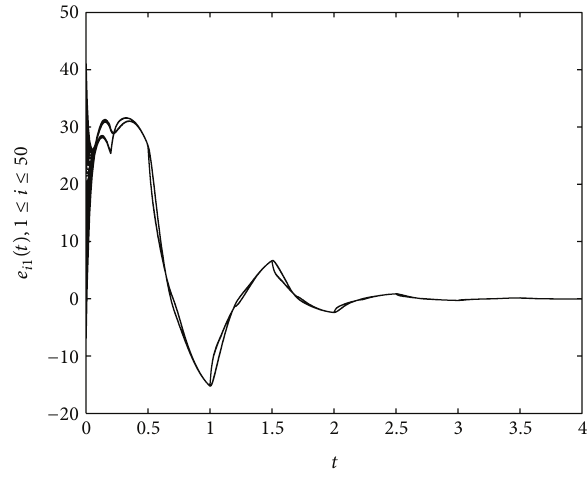
Figure 5: Synchronization errors 𝑒 𝑖 1 , 1 ≤ 𝑖 ≤ 50, with control parameters 𝑘 = 5, 𝑇 = 0 . 5, and 𝜃 = 0 . 4.